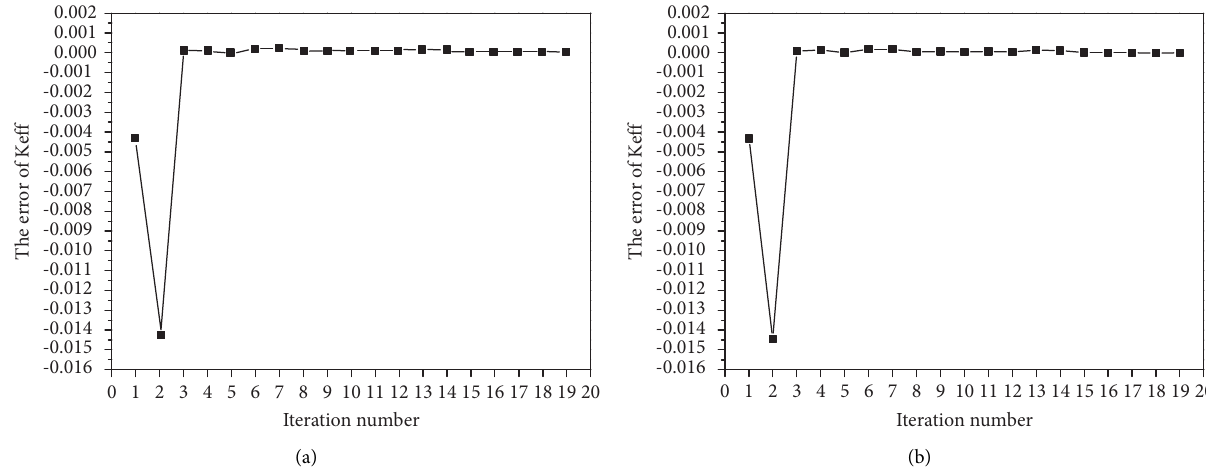
Figure 12: K versus the iteration number. (a) Block Gauss–Seidel scheme. (b) Block Jacobi scheme. eff